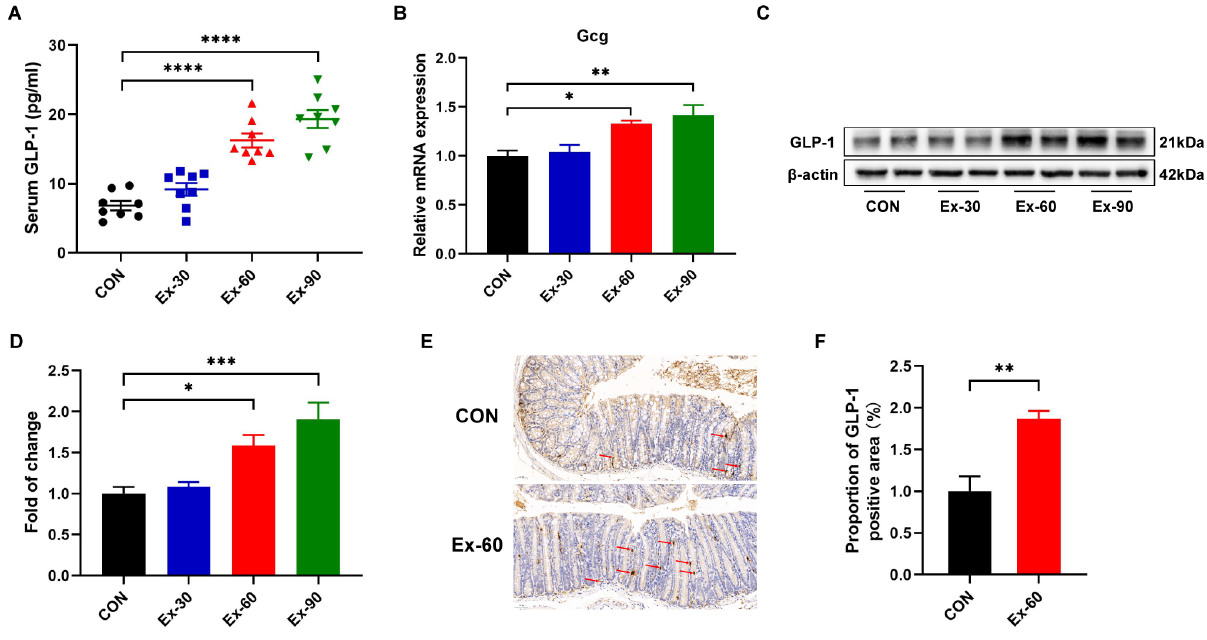
Figure 2. Two-week swimming training promotes GLP-1 secretion. ( A ) GLP-1 levels were measured using an ELISA kit in serum ( n = 8–10). ( B ) qPCR analysis of the expression of the Gcg gene in colon samples. ( C , D ) Representative western blot of GLP-1 from colon samples and quantification. ( E , F ) Immunohistochemistry staining of GLP-1 for colon samples and analysis of the proportion of GLP-1 positive area using Image J. Scale bars, 50 µ m. Data are expressed as the mean ± SEM. One-way ANOVA: ( A , B , D ). Unpaired t -test: F. * p < 0.05, ** p < 0.01, *** p < 0.001, and **** p <